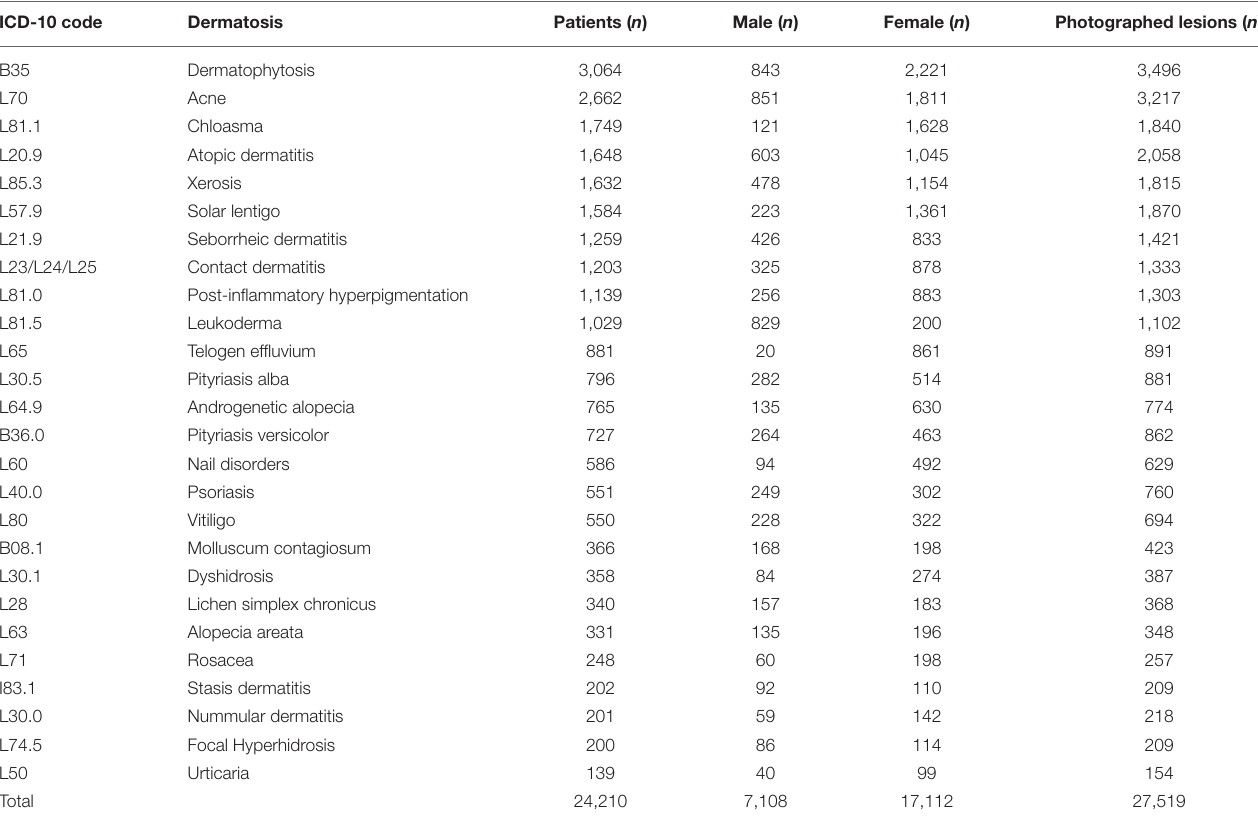
TABLE 2 | Most frequent inflammatory dermatoses diagnosed by teledermatologists according to number of patients, sex distribution, and number of photographed